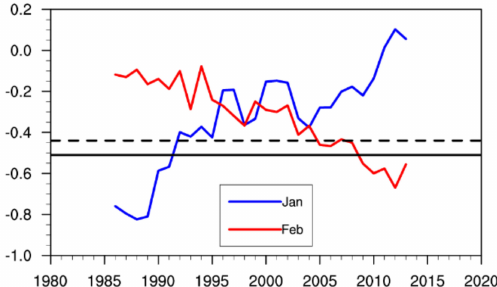
Figure 4. The time evolution of the 13-year running correlation of AO index with the average of ozone concentration in the lower stratosphere over the Arctic in January (blue line) and February (red line) during 1980–2019. The black dashed and solid line denotes the 90% and 95% confidence level based on the two-tailed Student’s t test